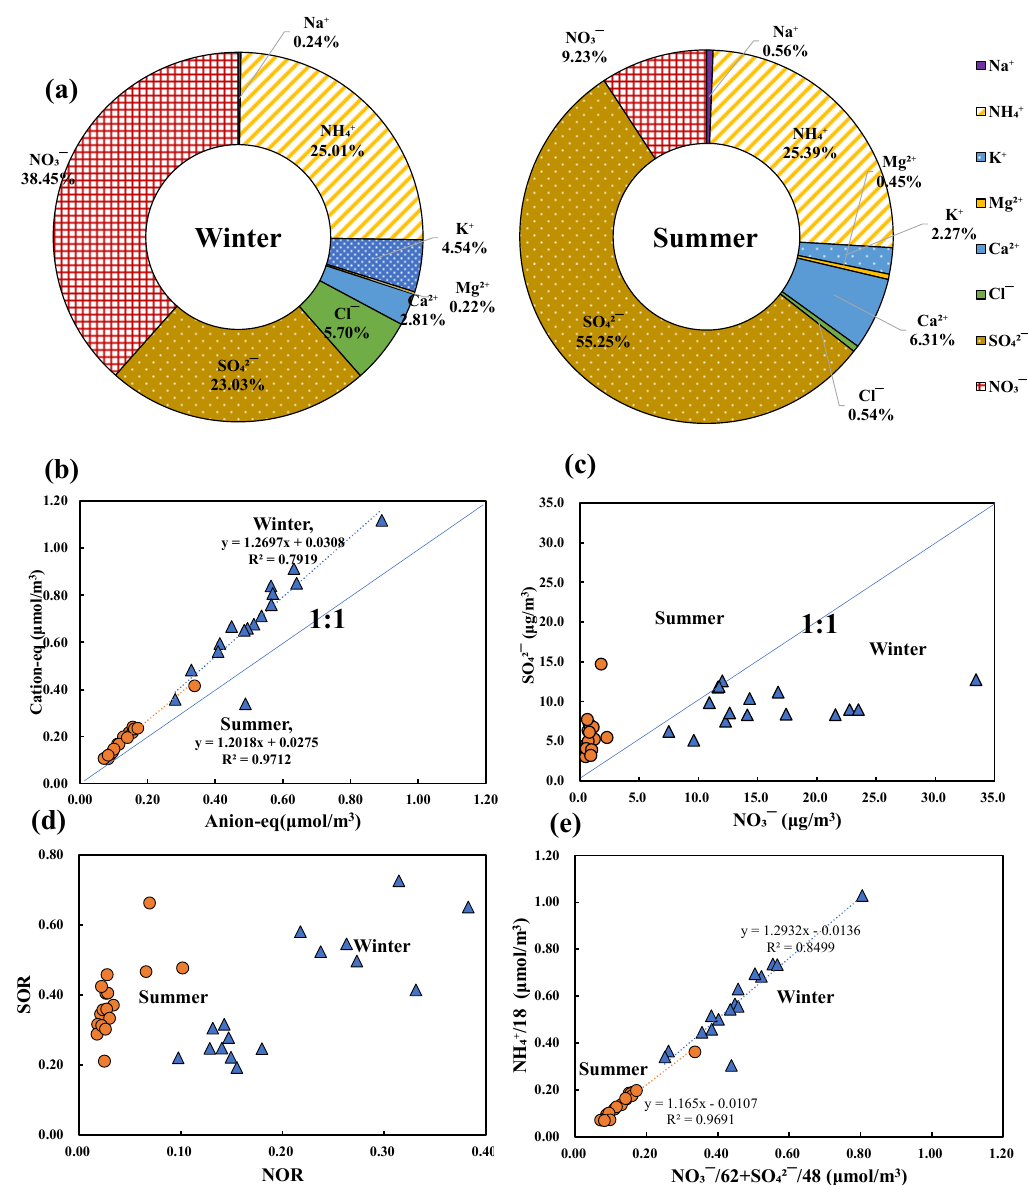
Figure 3. Chemical characteristics of species water-soluble ionic contents during winter and summer sampling periods. ( a ) Average proportion of each ion to total ions; ( b ) anion equivalent and cation equivalent; ( c ) NO 3 − and SO 42 − concentrations; ( d ) SOR and NOR; ( e ) equivalent of NO 3 − , SO 42 − and NH 4 +